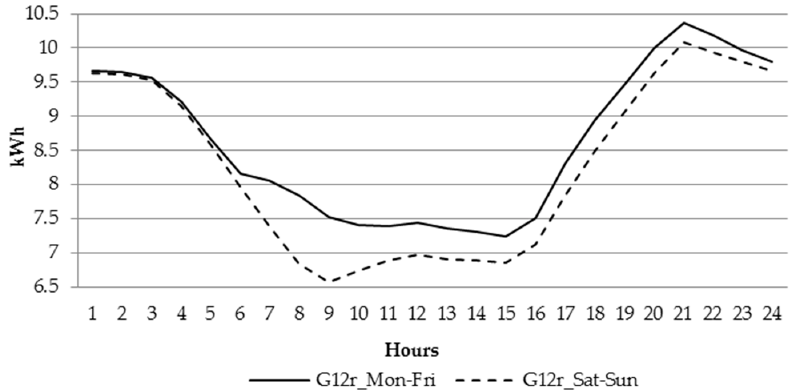
Figure 7. Working and weekend days average load profiles of the entities matching G12r characteristics.